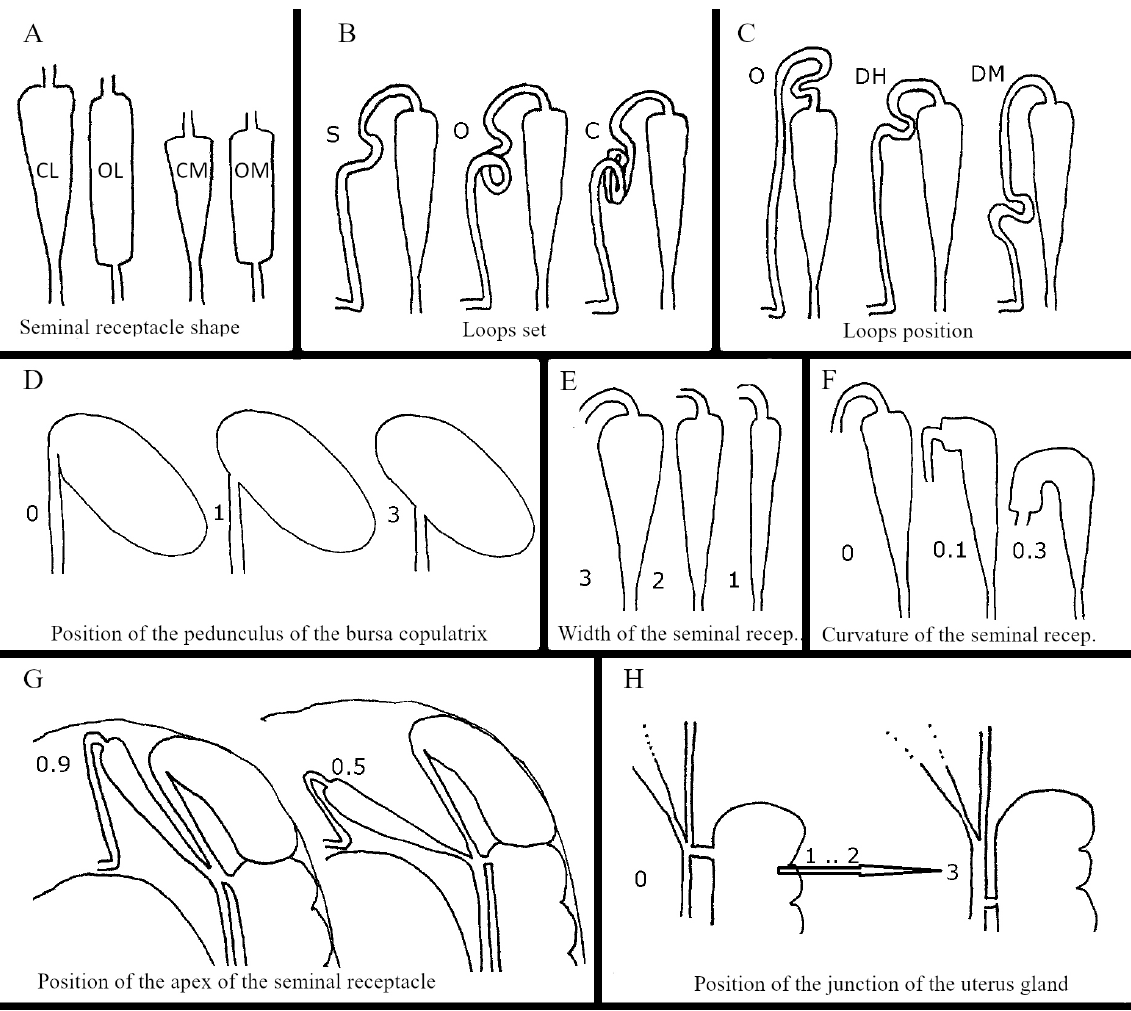
Fig 6. Female genital features. A . SR shape. B . Loops set up. C . Loops main position. D . CBC position. E . SR width. F . SR curvature. G . SR apex position. H . JUG